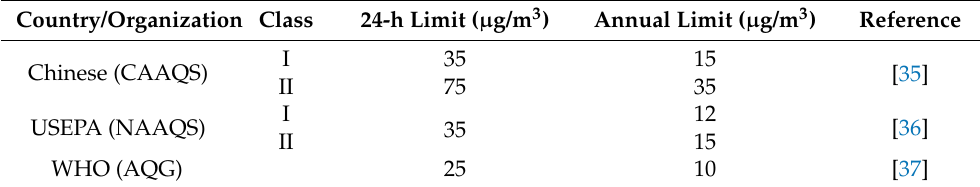
Table 1. Limit values for PM 2.5 in the Chinese, USEPA, and WHO standards.